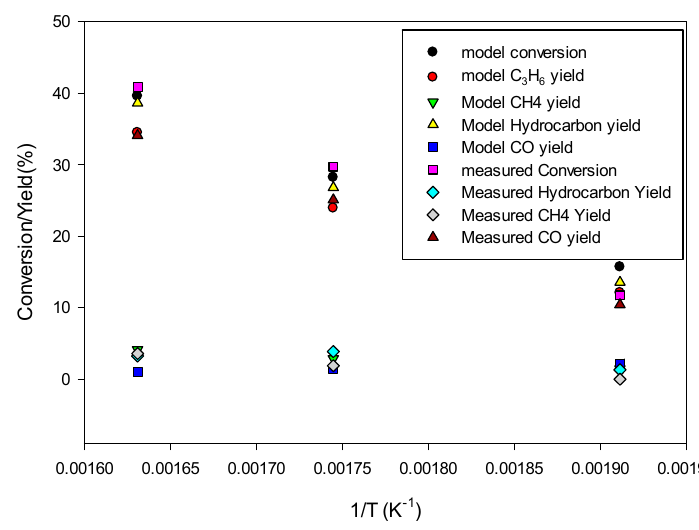
Figure 10. Comparison of model predictions with experimental data as functions of inverse temperature for 80Fe20Cu/K catalyst at reactor wall temperatures of 250 °C, 300 °C, and 340 °C and a gas hourly space velocity (GHSV) of 9.59 × 10 − 4 L/g s.